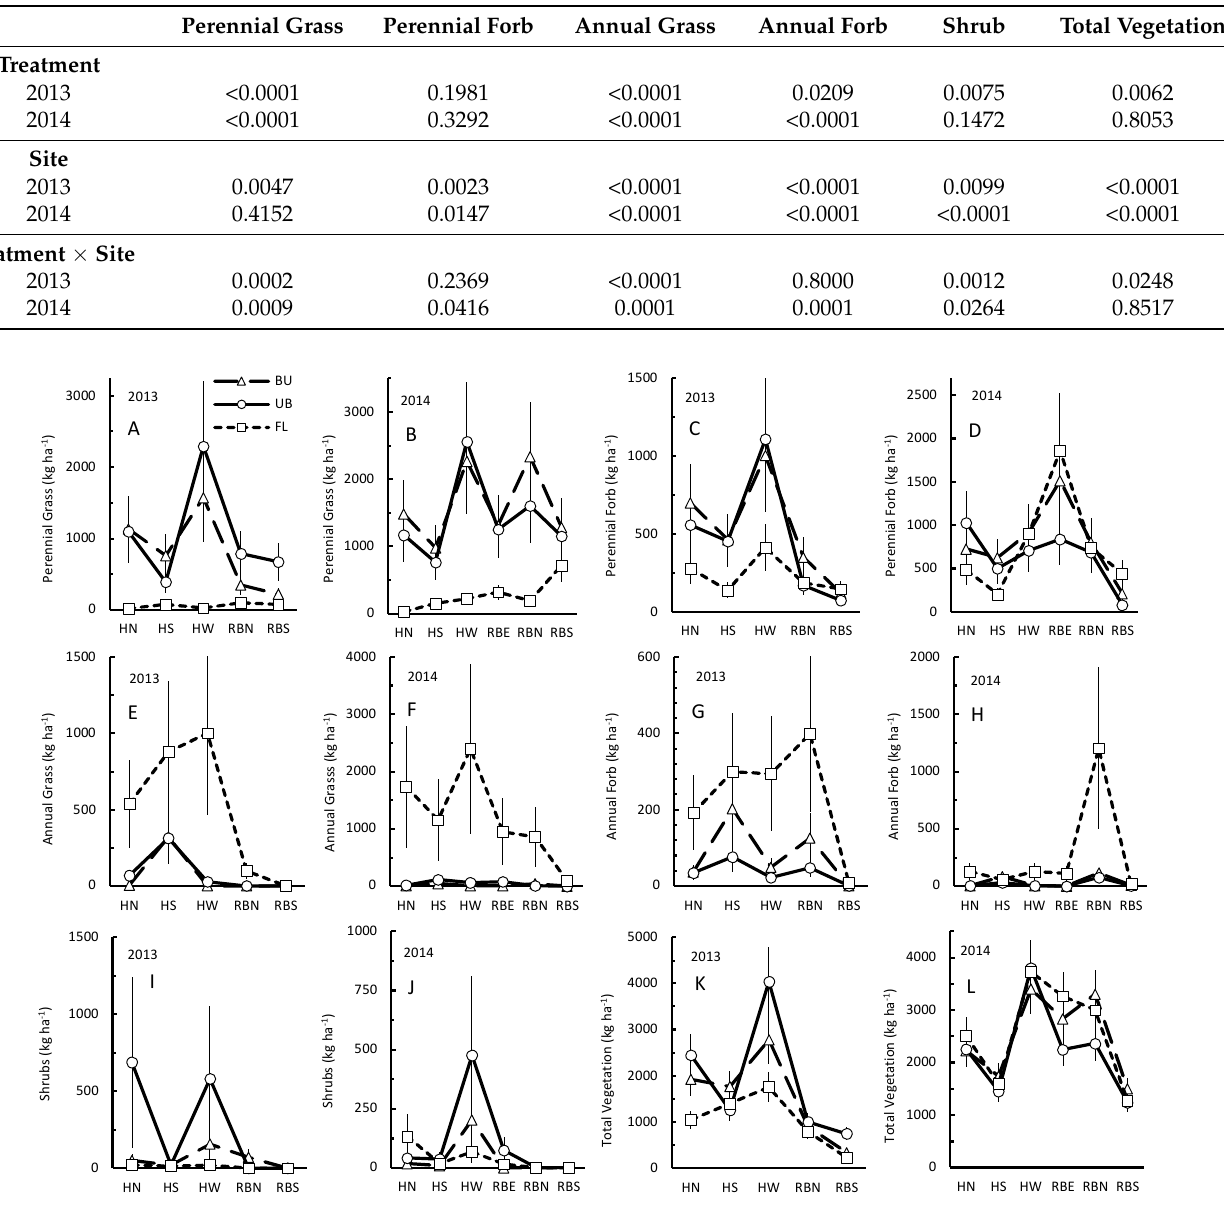
Table 1. P-values from Type III tests of the effects of treatment, site, and treatment and site interaction from generalized linear models with biomass response variables of total vegetation, perennial grass, perennial forb, shrub, annual grass, and annual forb for the years 2013 and 2014. Treatment × Site represents the treatment and site interaction.